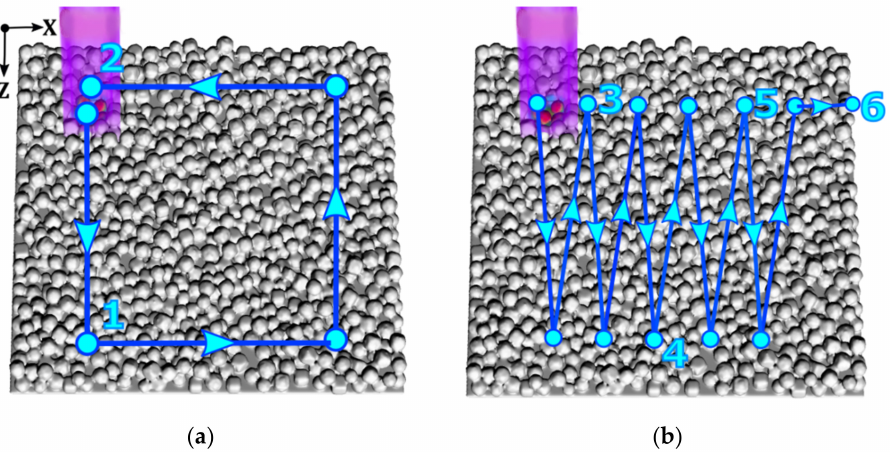
Figure 4. Laser exposure pattern applied to the powder bed. The first four segments are shown in ( a ), the remaining eleven segments are shown in ( b